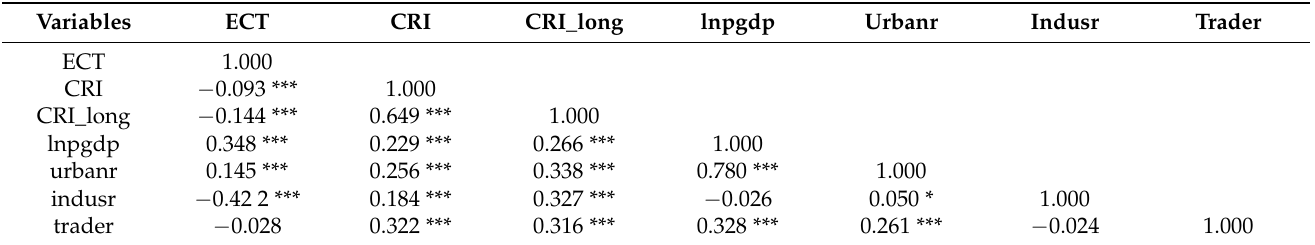
Table 3. Pearson correlation